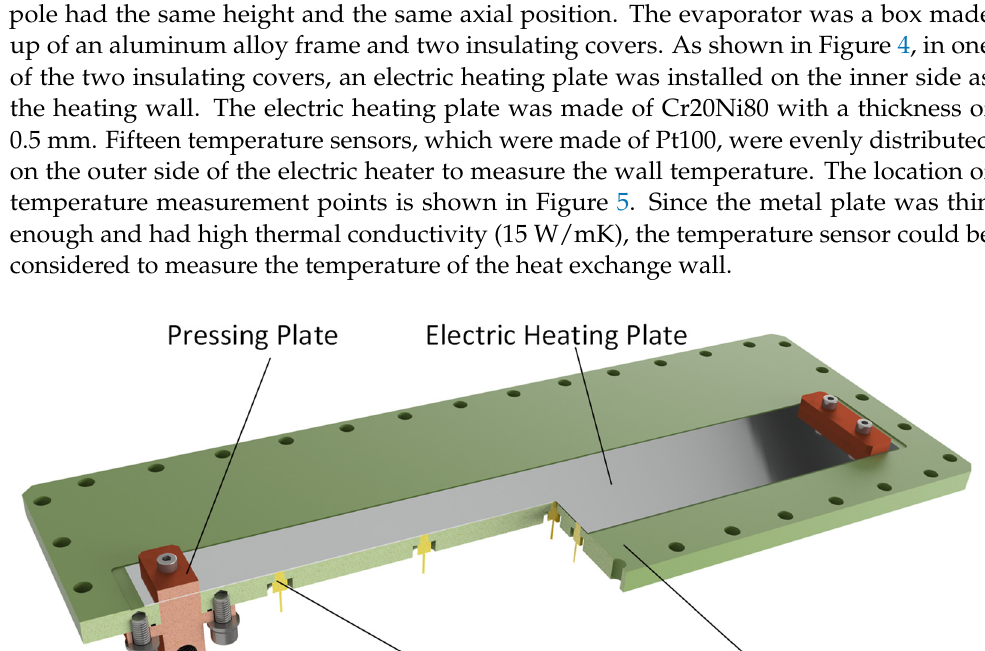
Figure 5. T he distribution of temperature sensors. Pressure monitoring is essential for the phase change cooling system. At the evapo- rator, the other insulating cover was fitted with pressure sensors. The positions of the pressure sensors corresponded to the temperature measurement points on the heating plate. Four pressure sensors were arranged at the inlet and outlet of the evaporator and condenser. In addition, the elbow near the inlet of the evaporator was at the lowest posi- tion of potential energy, where the static pressure was the largest. Pressure sensors were placed on the outside corner of the elbow to monitor the maximum pressure of the system. The measuring equipment and related parameters used in the experiment are listed in Table 1. Table 1. Summary of measurement devices. Device